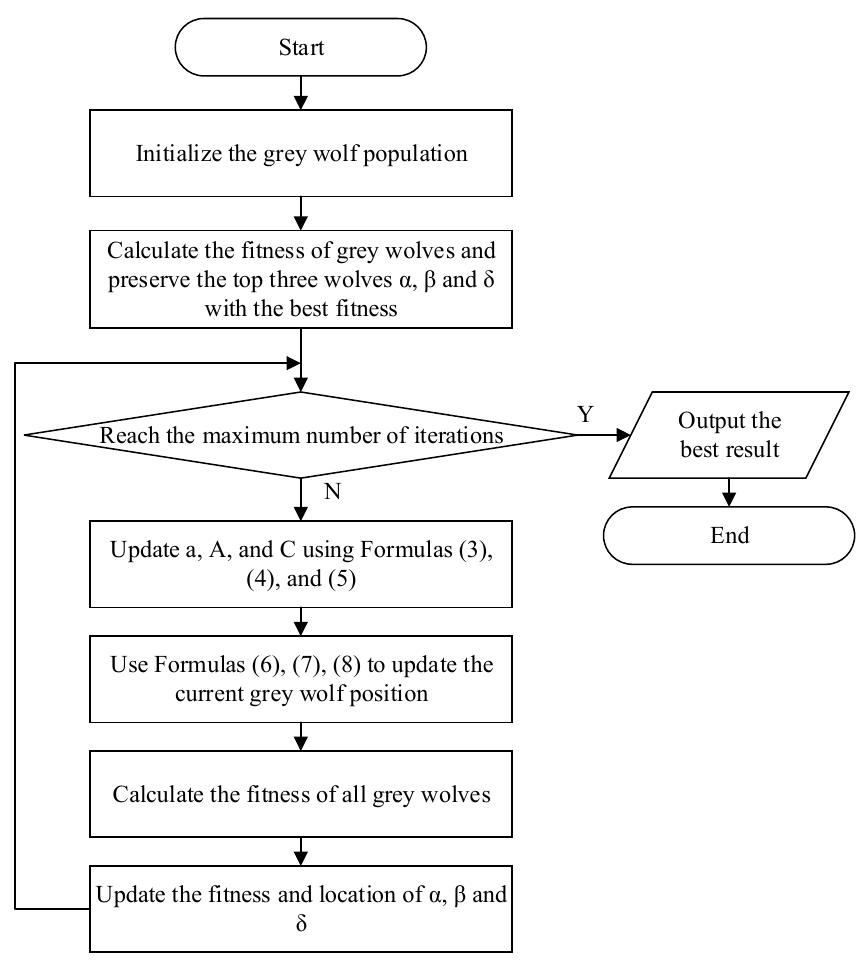
Figure 1. Flow chart of GWO